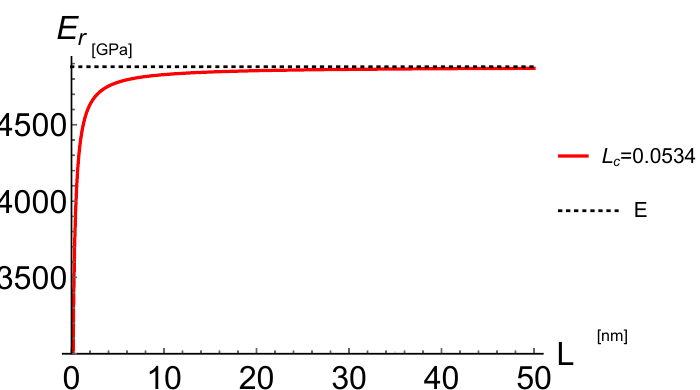
Figure 6. Plot the variation of the Young’s modulus obtained by the NSG method versus the SWCNT length for the nonlocal parameter L c = 0.0534 nm simulated by a CF nano-rod with a concentrated load at the free end. The data of the SWCNT are: diameter d = 1.4132 nm, effective thickness t = 0.0617 nm and Young’s modulus E = 4880 GPa.